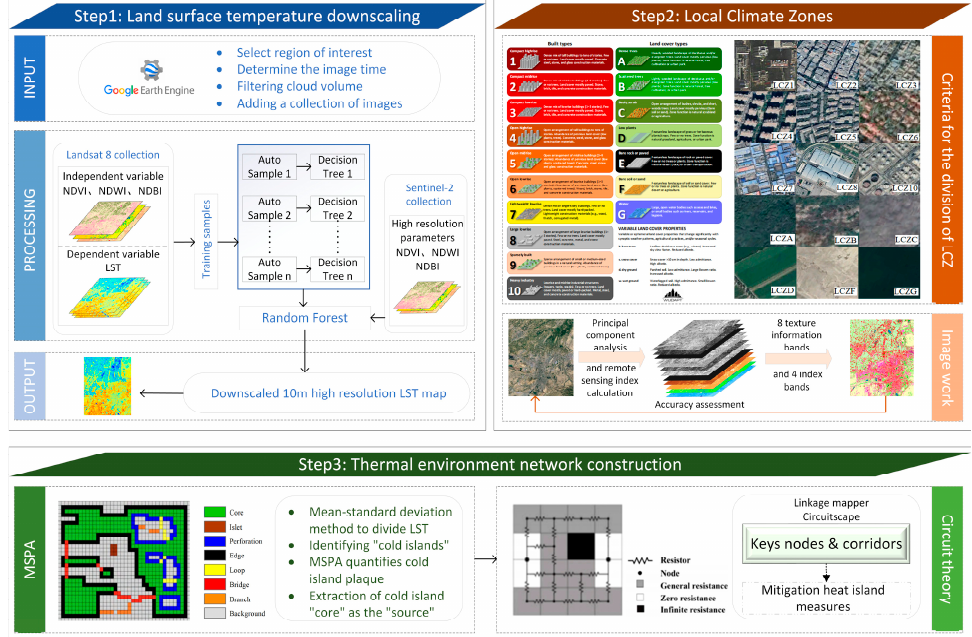
Figure 2. Research Framework